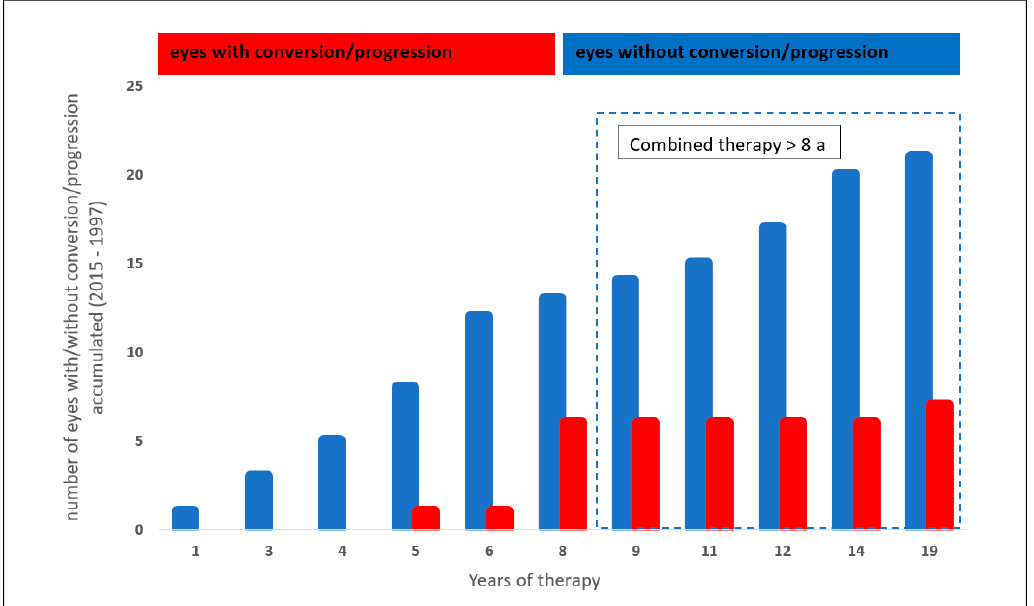
Figure 4. Effect of a combined statin and acetylsalicylic acid therapy on glaucoma conversion and glaucoma progression.